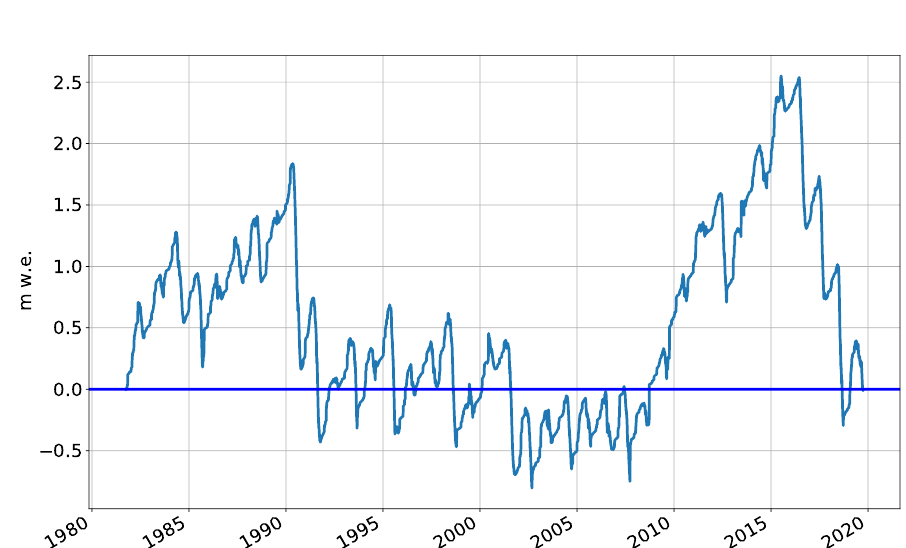
Figure A3. Cumulative climatic mass balance of temperature adjusted simulation of Halji glacier from 1981 to 2020. We apply a temperature offset of −0.37K to reach the long-term zero cumulative climatic mass balance which is needed for the computation of the seasonal sensitivity characteristic according to Oerlemans and Reichert [43].